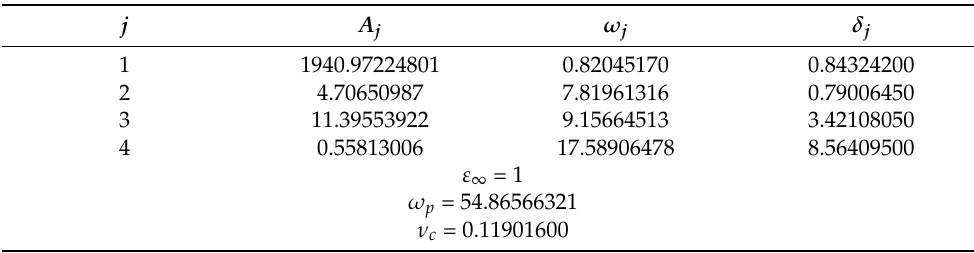
Table 3. Parameters for the Drude–Lorentz’s permittivity model of aluminum calculated using experimental results in [55,56].